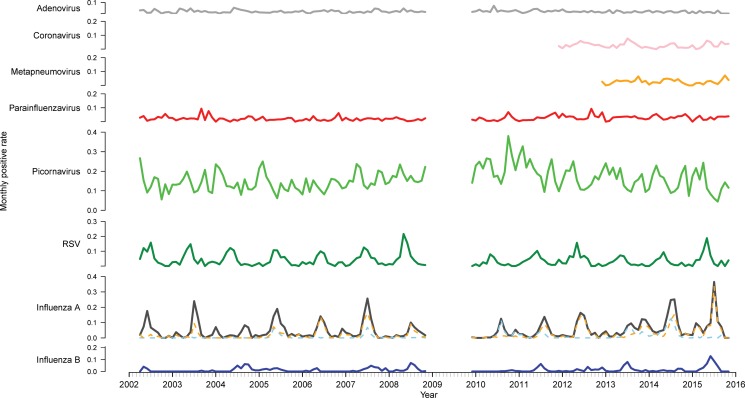
Time series of monthly virus detections. Data from 2009 were omitted as the influenza pandemic led to changes in referral practices. Influenza A is further divided into subtypes A(H3N2) (orange) and A(H1N1) (blue).